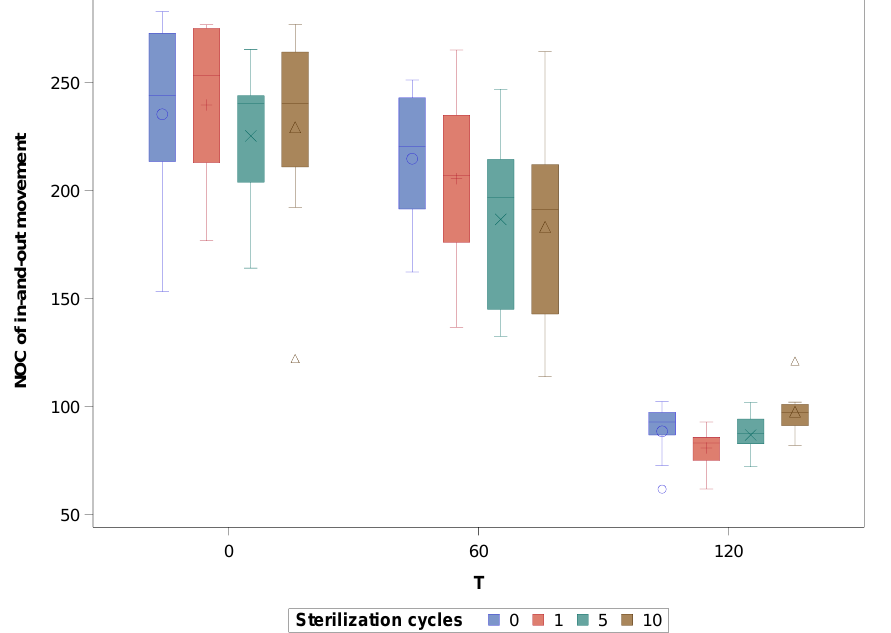
Figure 7. Box plot of the number of cycles of in-and-out movement for the time of use and sterilization cycles study groups. The horizontal line in each box represents the median value.